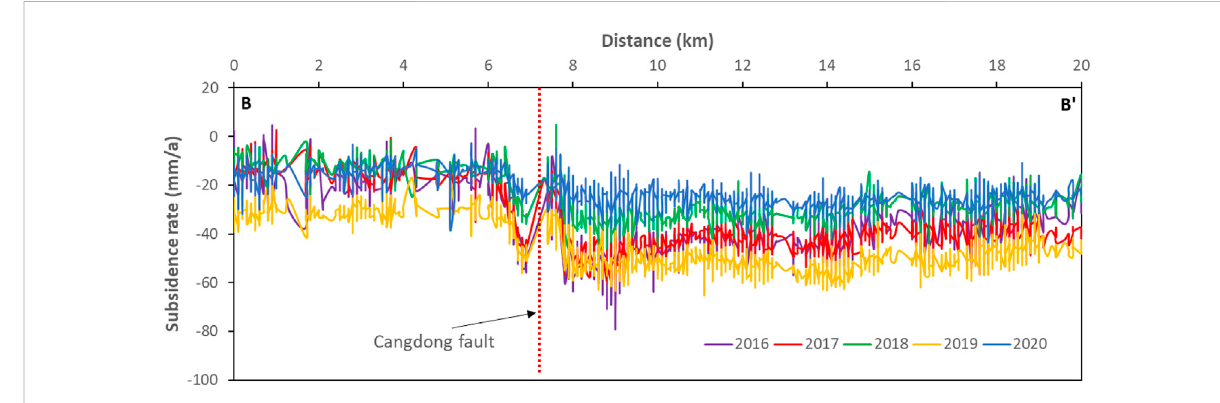
FIGURE 12 Variation of subsidence rate with distance from 2016 to 2020 for the BB ′ section (see Figure 1 for the section